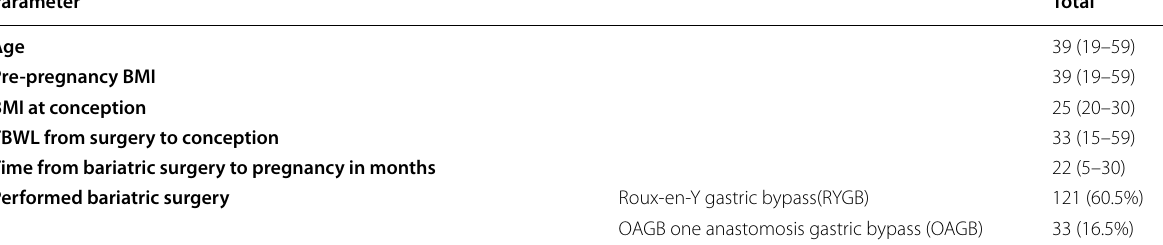
Table 1 Pre‑pregnancy characteristics and pregnancy and neonatal outcomes of the whole group